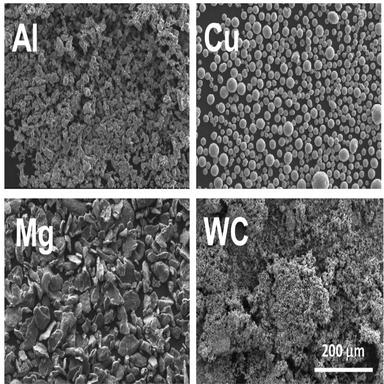
Scanning Electron Microscopy-Secondary Electron (SEM-SE) images of Al, Cu, Mg, and WC powders.